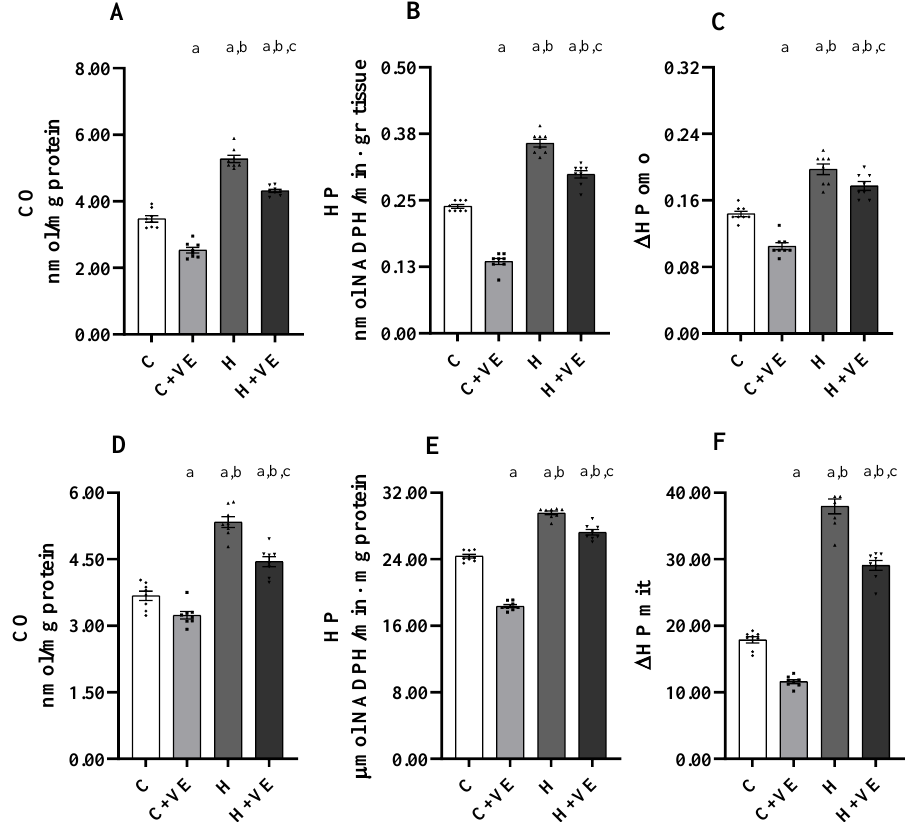
Figure 2. Oxidative stress markers (protein-bound carbonyls, CO, panels ( A , D ); and lipid hydroper- oxides, HP, panels ( B , E )) and in vitro response to oxidative stress ( ∆ HP, panels ( C , F )), in skeletal muscle ( upper panels ) and mitochondria ( lower panels ). C control rats; C + VE, vitamin-E-fed rats; H hyperthyroid rats; H + VE hyperthyroid and vitamin-E-fed rats. Values are the means ± SEM of eight different rats. p < 0.05 was chosen as the significance level. Meaning of the letters: a, p < 0.05 vs. C; b, p < 0.05 vs. C + VE; c, p < 0.05 vs. H (one-way ANOVA followed by Tukey post-test).